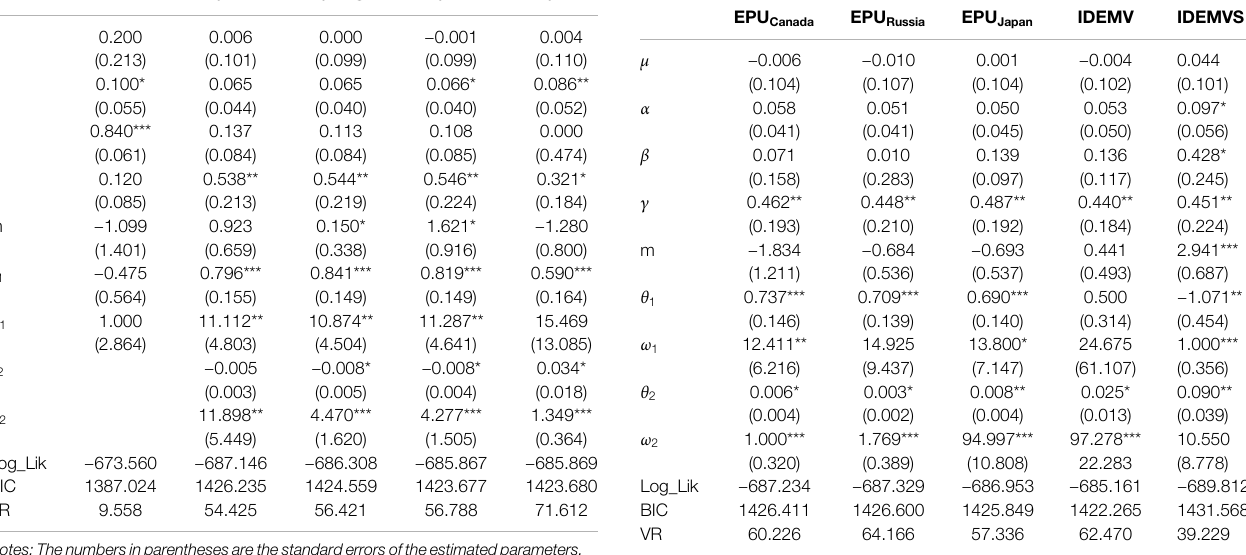
TABLE 4 | Estimation GARCH-MIDAS models with economic policy uncertainty and infectious disease pandemic.